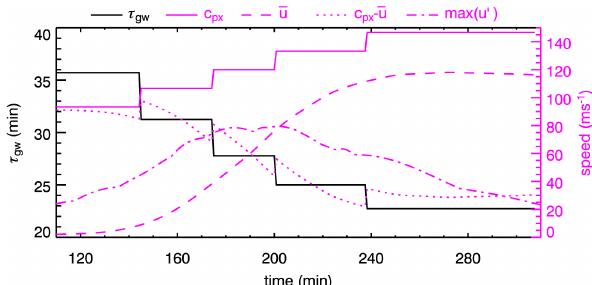
Figure 3. Temporal evolution of GW period ( τ gw , left axis, the black solid line), mean wind ( ¯ u , right axis, the red dash line), the ap- parent horizontal phase velocity ( c px , right axis, the red solid line), the amplitude of perturbation wind (max (u 0 ) , right axis, the red dash-dot line) and the intrinsic horizontal phase velocity ( c px − ¯ u , right axis, the red dot line) for the case EM at